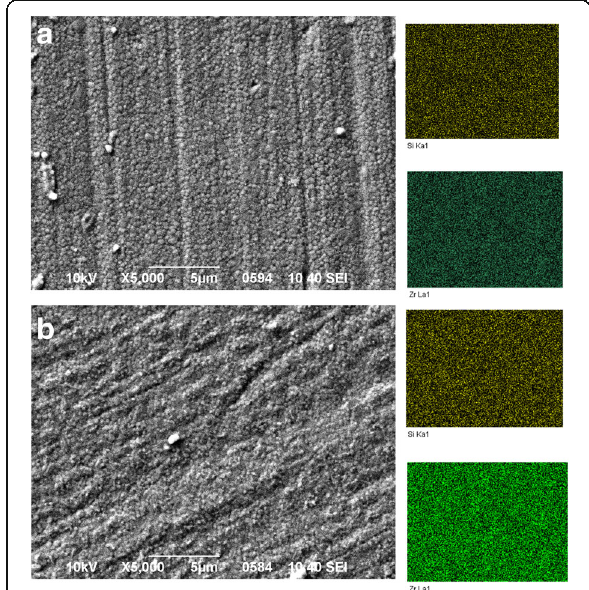
Fig. 6 The SEM images and EDX mapping analysis of sintered to 1500 °C samples ( a ) 3Y-TZP-0.2 wt% SiO 2 , and b PMM8-3Y-TZP-0.2 wt% SiO 2